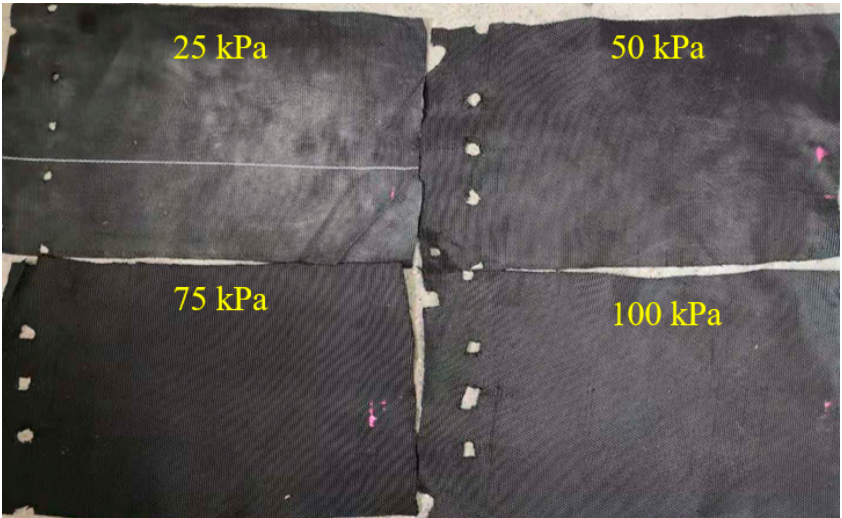
Figure 6. P-type interface after the pull-out test.